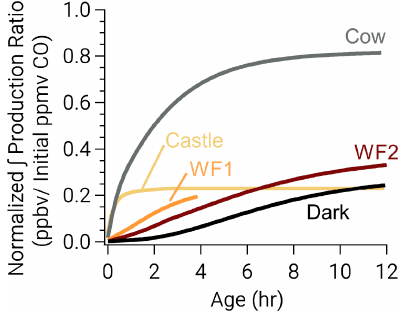
Figure 8. Integrated nitrophenolic production normalized to initial CO to compare nitrophenolic production across varying amounts of initial emissions. The simulated Castle and Cow plumes form nitrophenolics quickly. Even so, the Castle plume forms less nitro- phenolics than other